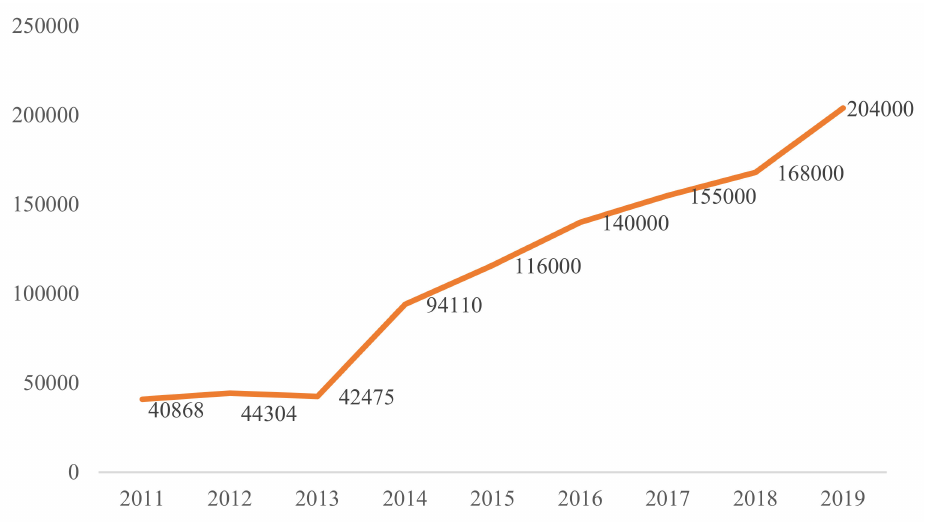
Figure 1. The growth in the number of nursing homes in China